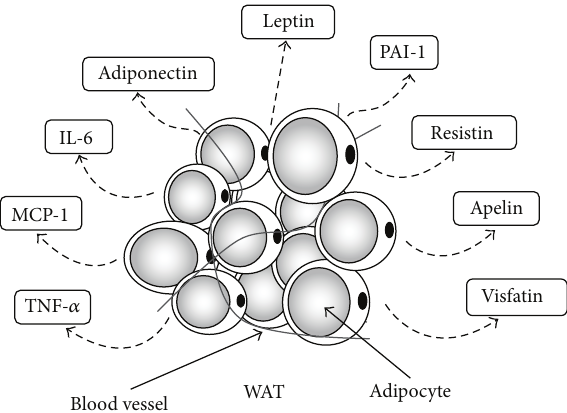
Figure 1: Adipokines secreted by white adipose tissue. White adipose tissue (WAT) secretes various humoral factors called adipokines. Adipokines have important effects on lipid and glucose metabolism, and so on. TNF- 𝛼 , tumor necrosis factor- 𝛼 ; MCP- 1, monocyte chemoattractant protein-1; IL-6, interleukin-6; PAI-1, plasminogen activator